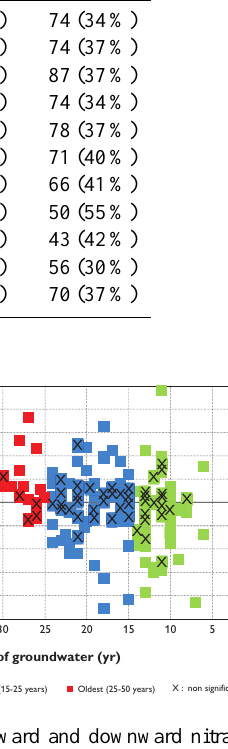
Table 2. Distribution statistics of annual agricultural N surpluses from 1950 to 2007 in 10 different geo-regions of Denmark, and in Denmark as a whole. Geo- Geo-region 1950 Max 2007 Mean Increase Reduction region No.